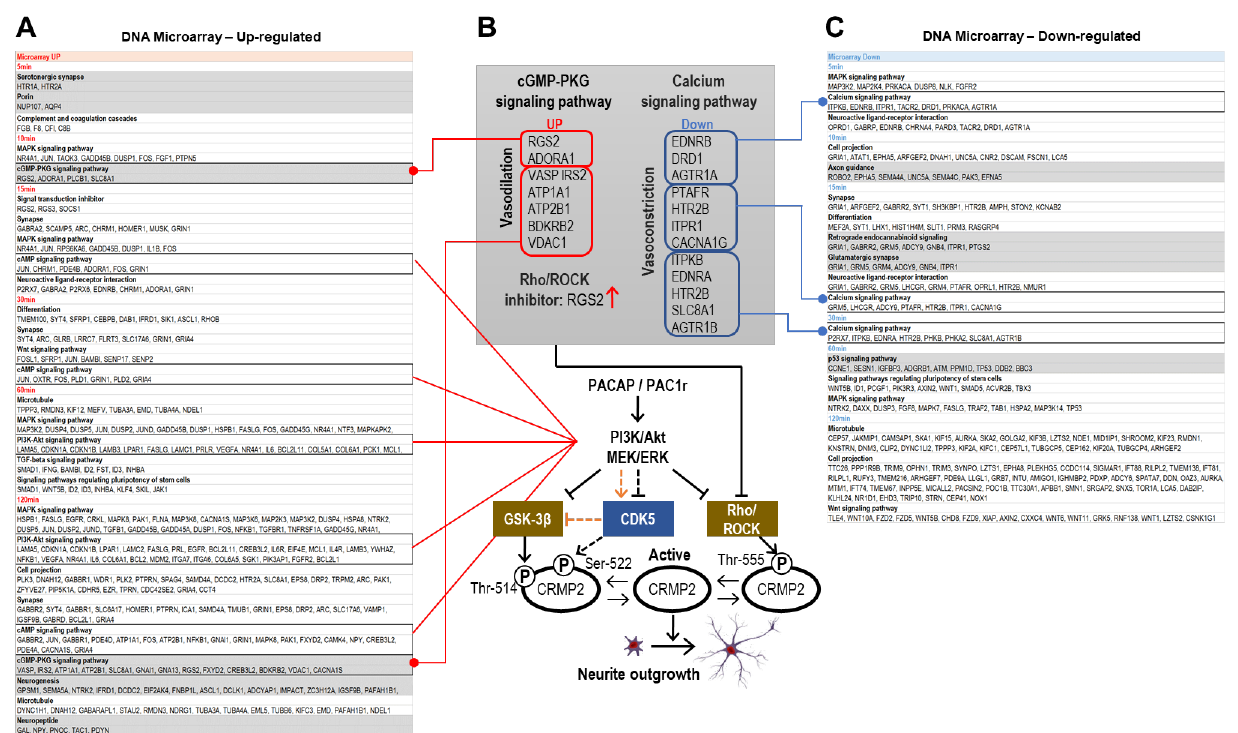
Figure 6. Categorical analysis using the DAVID tool of the genes (2.0-fold ≥ , 0.5-fold ≤ ) whose expression was altered by PACAP obtained through the DNA microarray analysis. The categories mentioned in the discussion are in gray, and the categories thought to be involved in the Pac1r- mediated neurite projection elongation effect of PACAP shown in B are circled with black lines. ( A ) Categories of genes whose expression was increased by PACAP. ( B ) Genes categorized in the cGMP-PKG signaling pathway and Calcium signaling pathway that have functions of vasodilation and vasoconstriction may be involved in Rho/ROCK inhibition; red boxes, up-regulated genes; blue boxes, down-regulated genes. The red arrow indicates a strong up-regulation of the RGS2